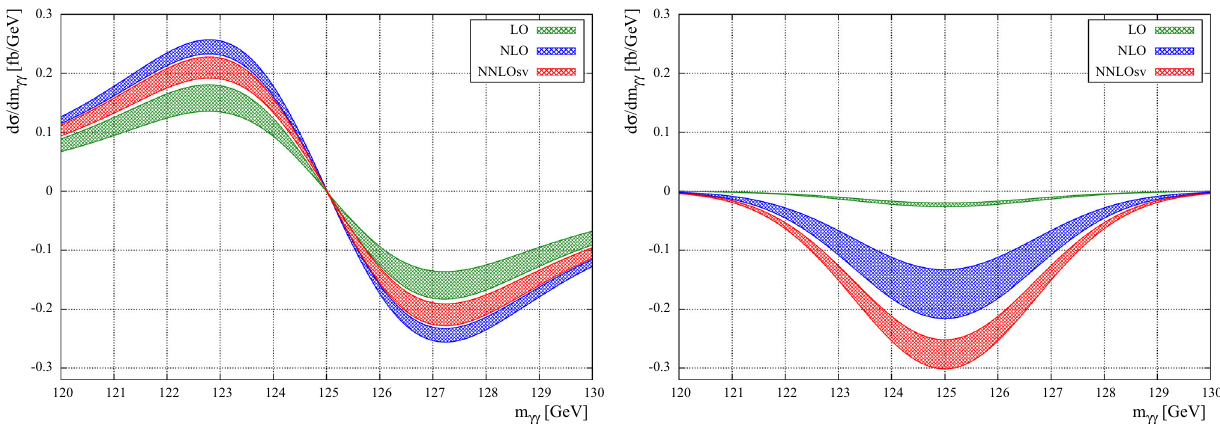
Fig. 5 Real part (left pane) and imaginary part (right pane) of the interference at LO, NLO and NNLOsv after Gaussian smearing